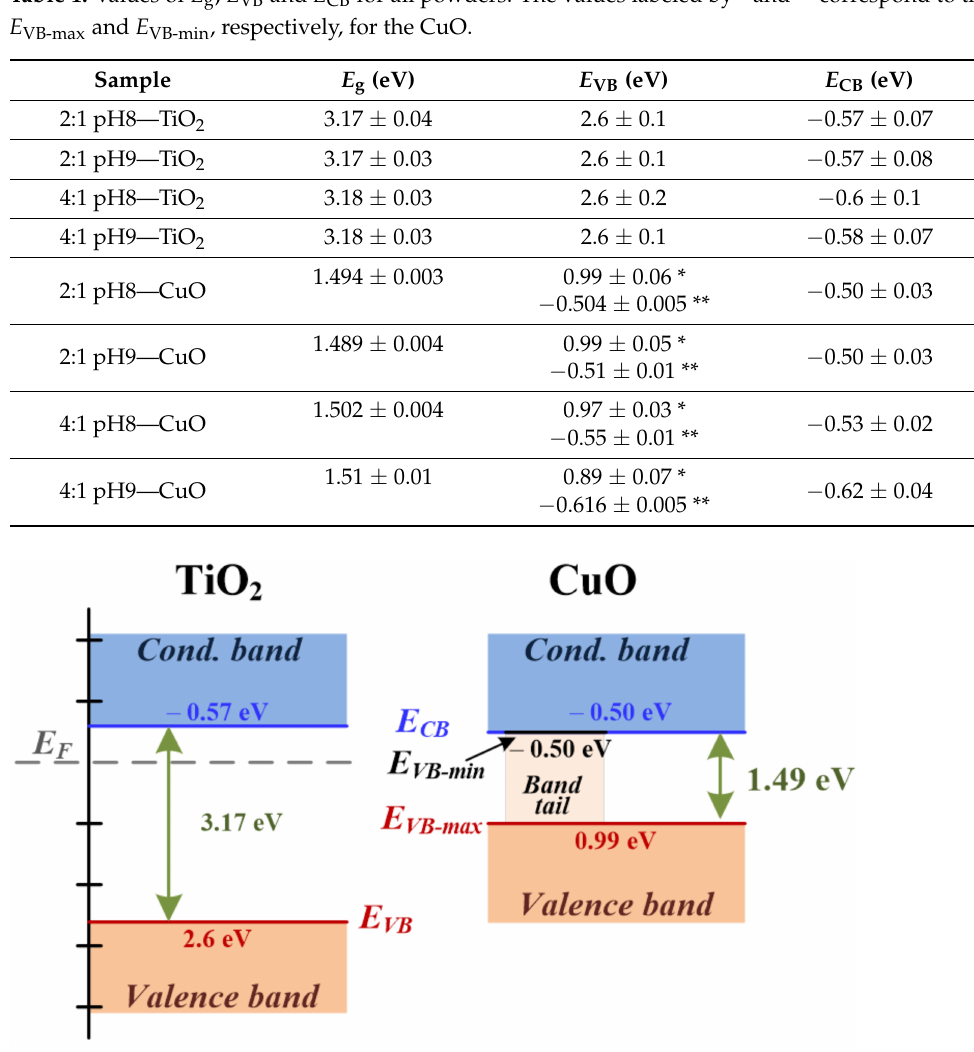
Figure 11. Schematic diagram of the energy bands for the TiO 2 and CuO powders. The values of the energy levels correspond to the powders synthesized by following the 2:1 pH8